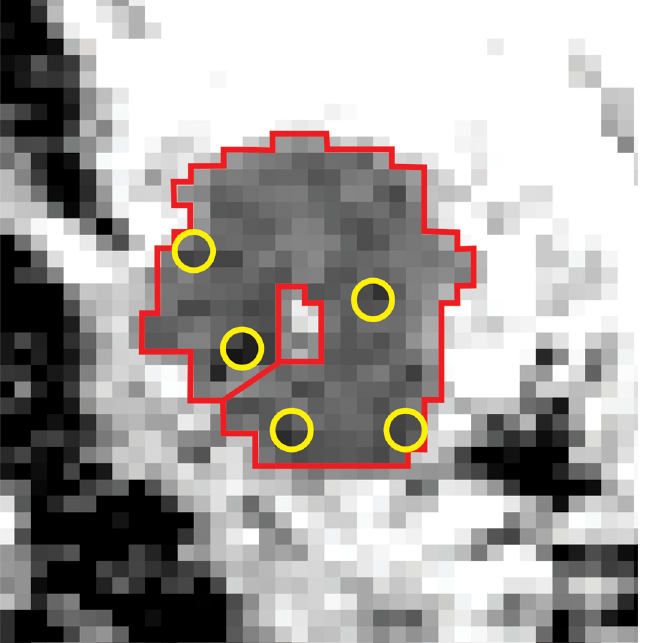
Fig 2. Whole lesion ( red ) and small ( yellow ) region of interest (ROI) placement on a diffusion-weighted image (DWI) of the right breast of a 41-year-old